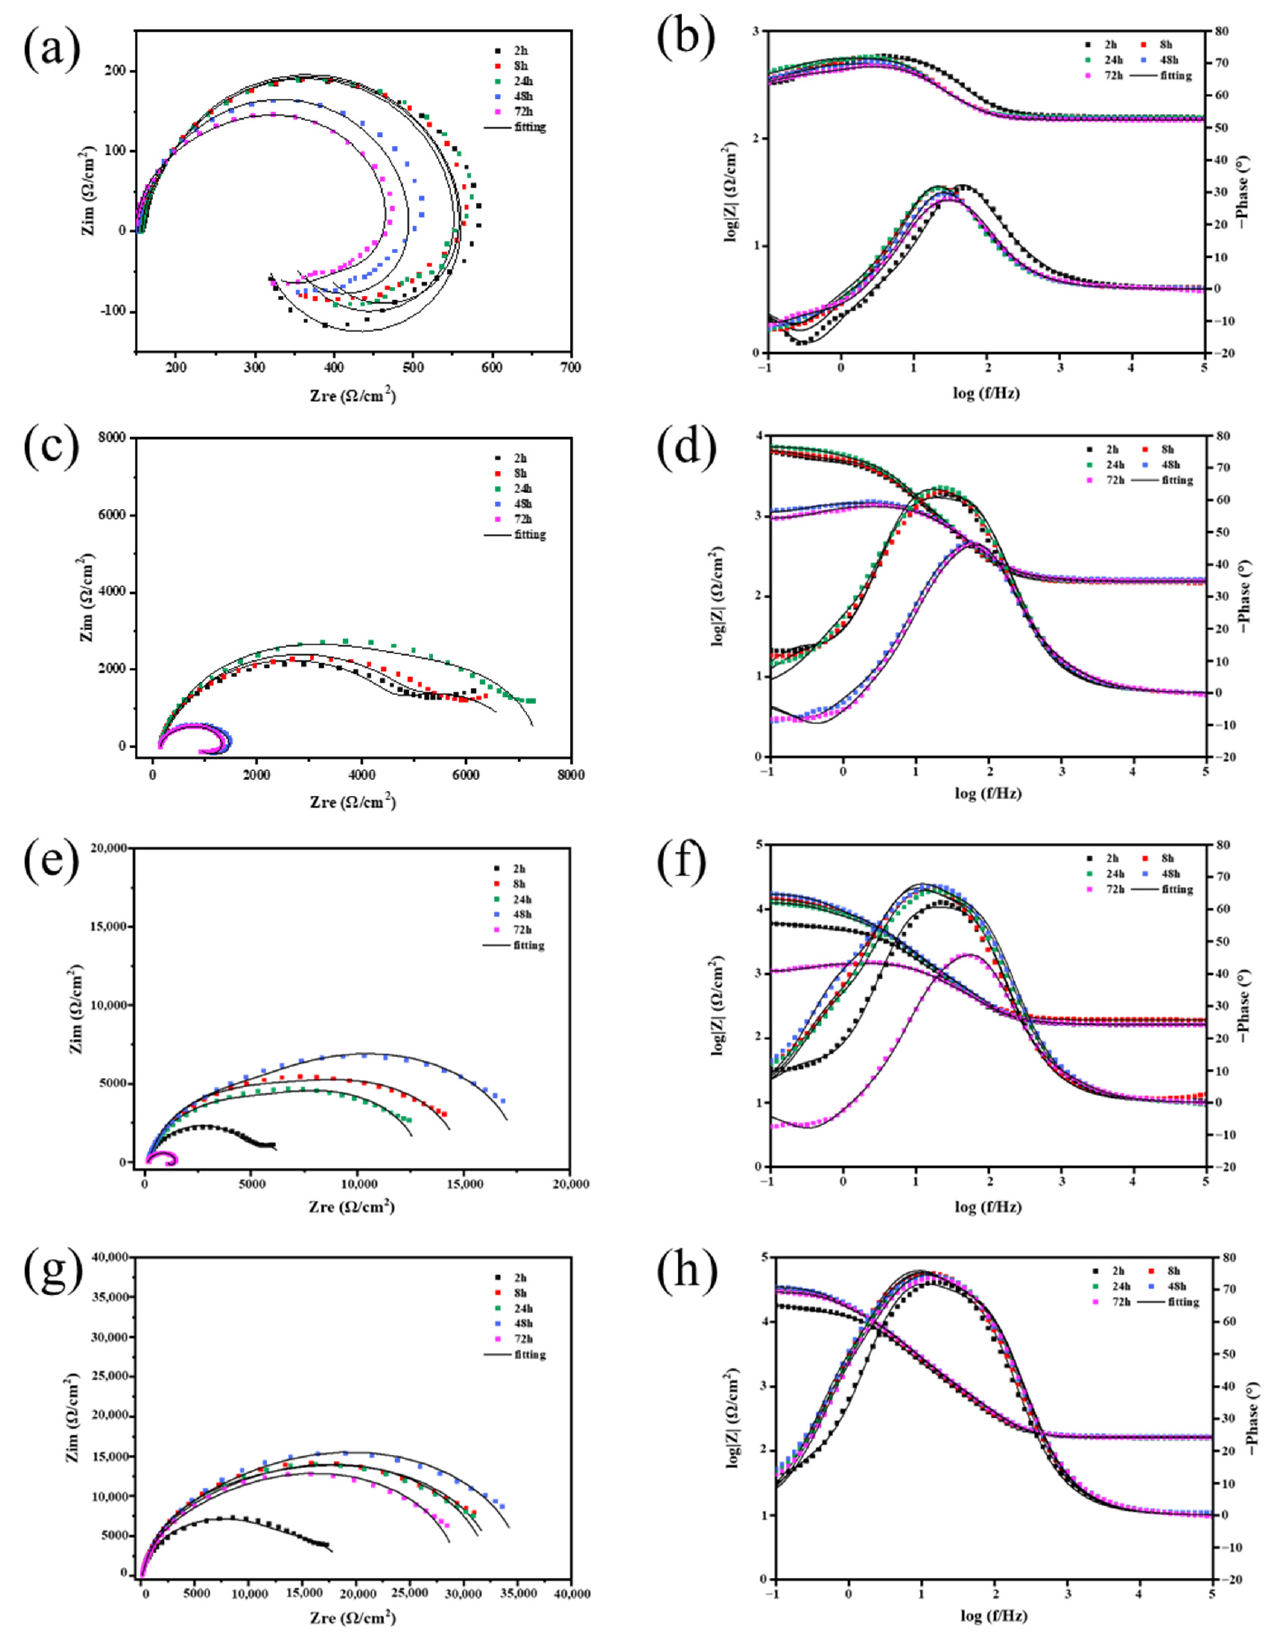
Figure 5. EIS of a series of immersion times of ( a , b ) Bare AZ31B alloy, ( c , d ) Ce(IV)/PEI/PAA, ( e , f ) Ce(IV)/PEI-C/PAA, and ( g , h ) Ce(IV)/PEI-C/PAA-GO in a 3.5 wt% NaCl solution.